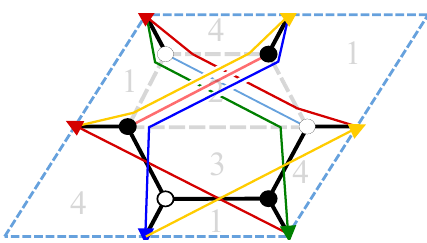
Figure 19. Backreaction using the naive local recipe. This (cid:12)gure should be compared with (cid:12)gure 18b, which correctly exploits global